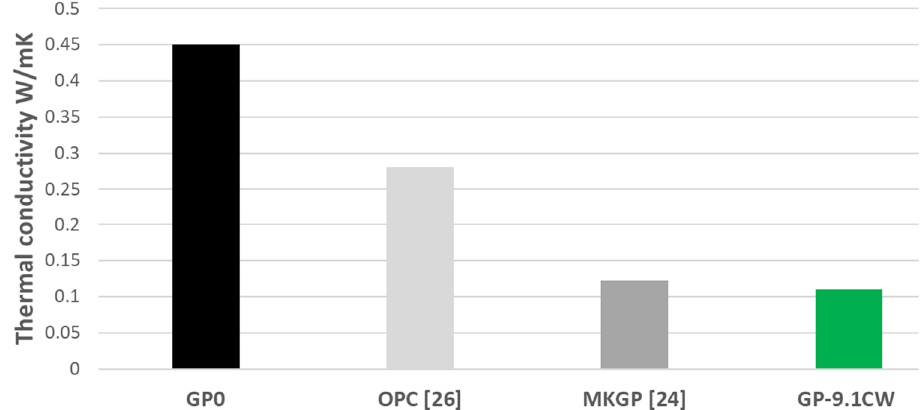
Figure 9. Thermal conductivity values for samples GP0 and GP-9.1CW after 28 days compared to the literature data of aerated Portland cement (OPC) and porous MK-based geopolymers (see text for explanation).